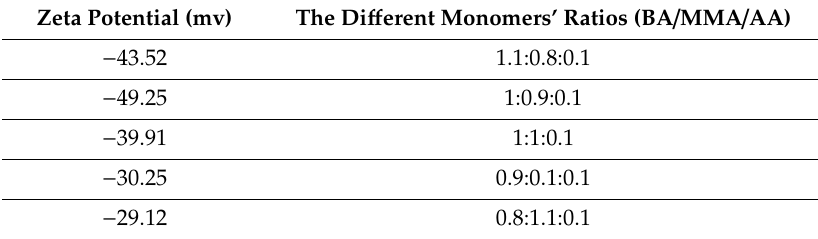
Table 1. Zeta potential (mv) of di ff erent monomers’ ratios (BA / MMA / AA).